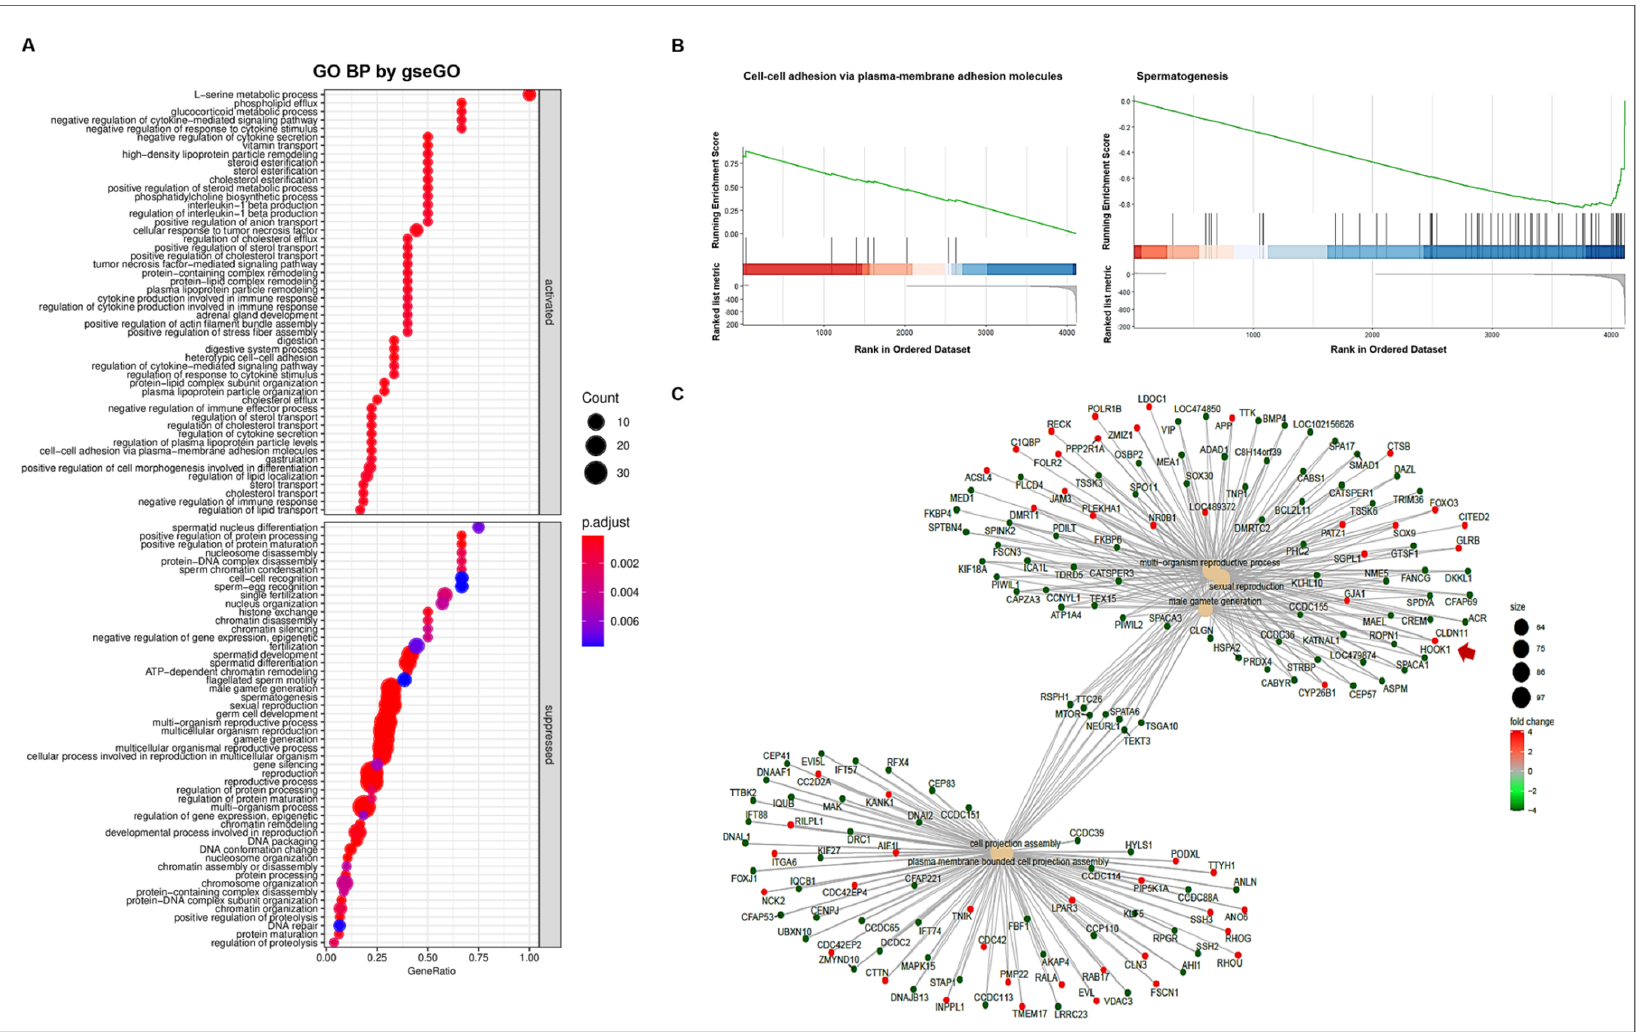
Figure 4. GO enrichment analysis. ( A ) The enriched GO biological processes. The GO annotations were divided into two groups namely activated and